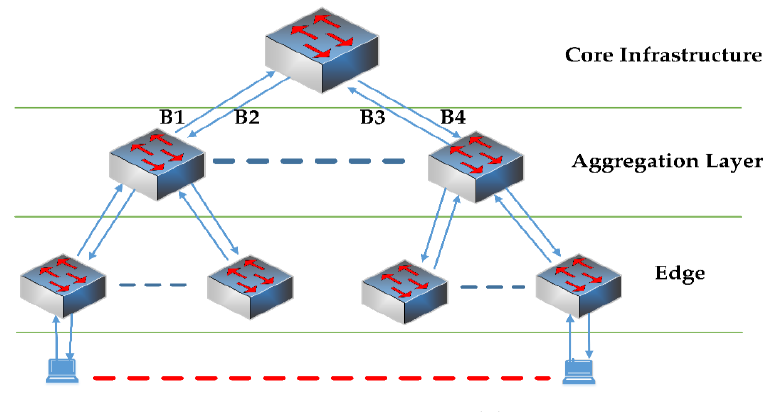
Figure 1. GANA Figure 1. GANA model.